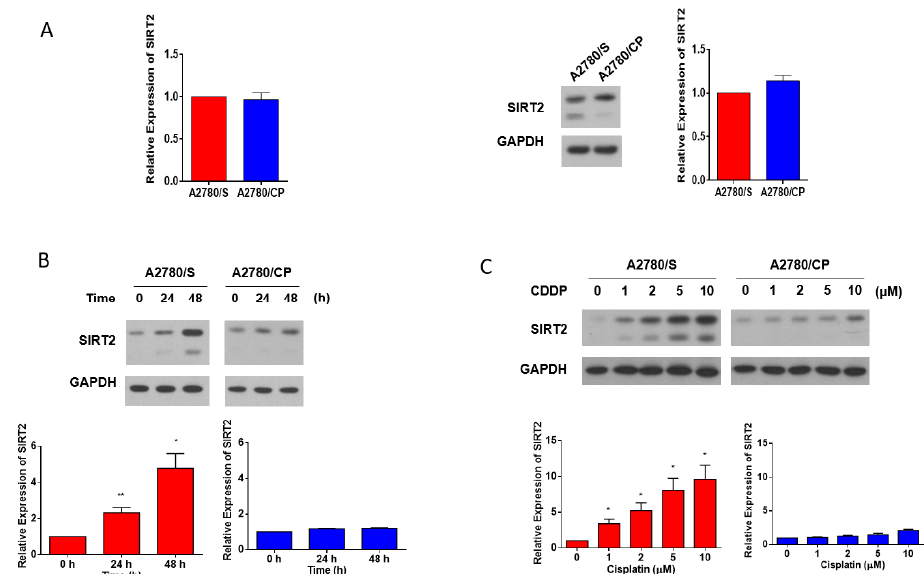
Figure 4. SIRT2 basal expression in the A2780/S and A2780/CP cells were evaluated at the mRNA level and protein level ( A ). SIRT2 expression was detected in the A2780 / S and A2780 / CP cells with level and protein level ( A ). SIRT2 expression was detected in the A2780/S and A2780/CP cells with cisplatin treatment (2 µ M) for 24 and 48 h ( B ). The expression of SIRT2 was detected in the A2780 / S and cisplatin treatment (2 μ M) for 24 and 48 h ( B ). The expression of SIRT2 was detected in the A2780/S A2780 / CP cells with cisplatin treatment in di ff erent concentrations ( C ). Results are shown as mean ± and A2780/CP cells with cisplatin treatment in different concentrations ( C ). Results are shown as SEM (* p ≤ 0.05, ** p ≤ mean ± SEM (* p ≤ 0.05, ** p ≤ 0.01).